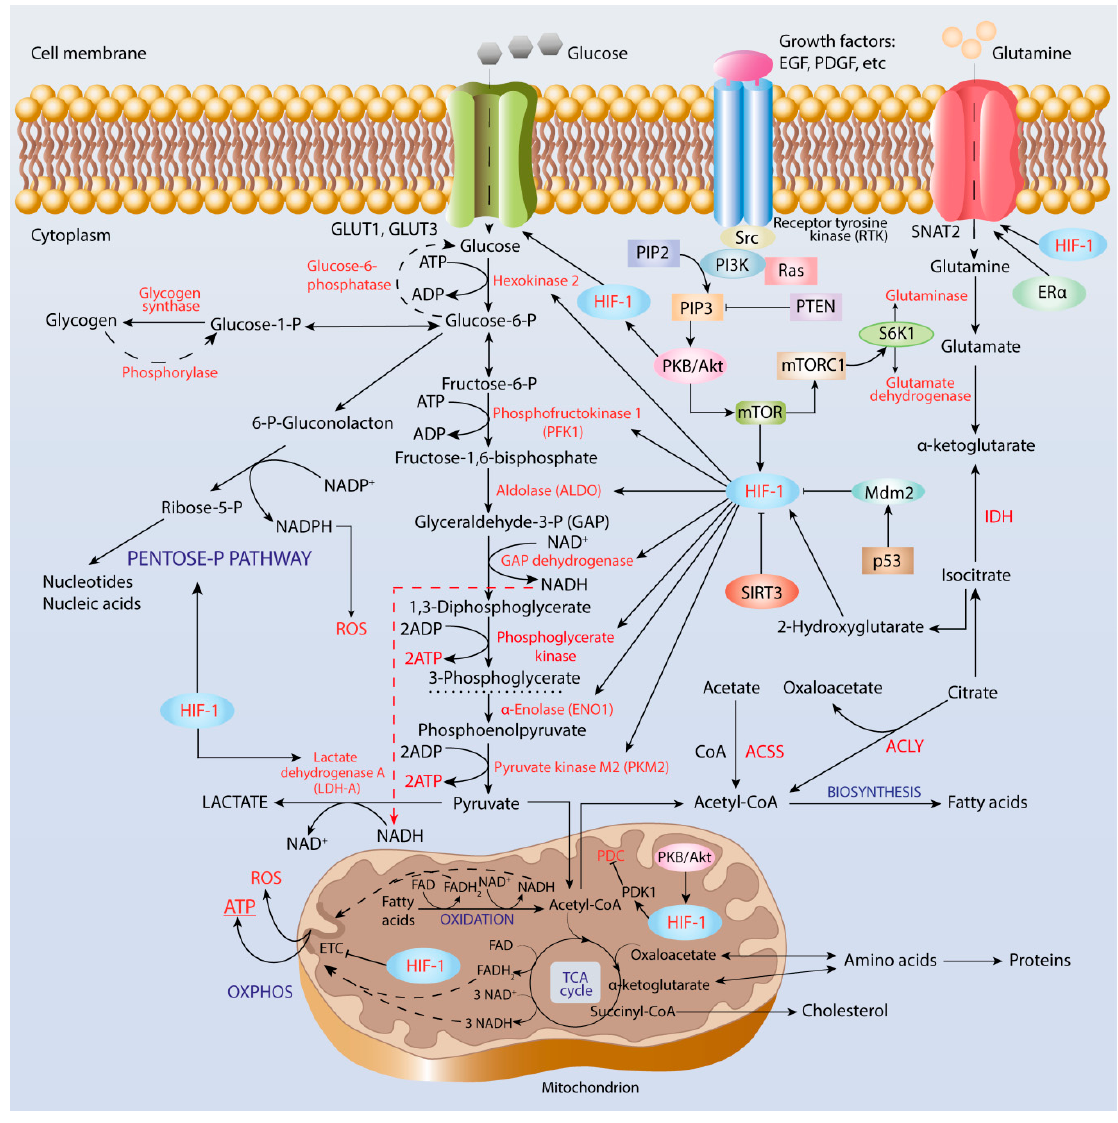
Figure 1. Regulation of metabolic reprogramming in cancer cells. Hypoxia-inducible factor-1 (HIF-1) induces expression of genes, which encode glucose transporters, GLUT1 and GLUT3, enzymes of glycolysis and pentose-phosphate pathway, and pyruvate dehydrogenase complex kinase. Activity of HIF-1 is regulated by Ras-protein kinase B (PKB)/Akt-mammalian target of rapamycin (mTOR) axis.